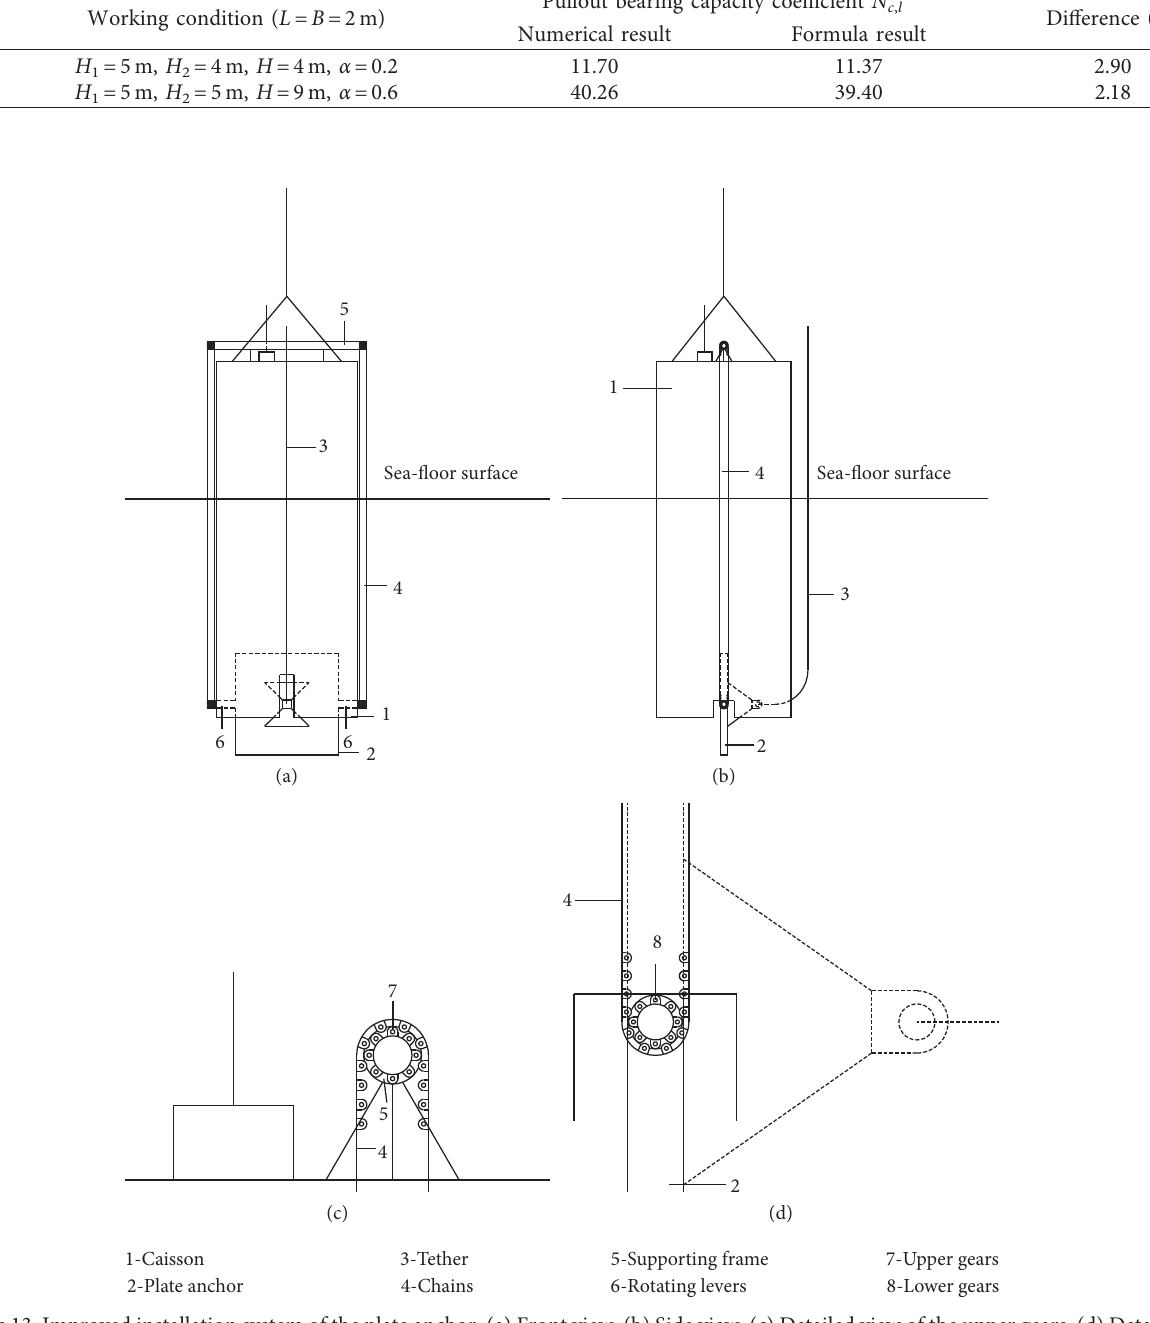
Figure 13: Improved installation system of the plate anchor. (a) Front view. (b) Side view. (c) Detailed view of the upper gears. (d) Detailed view of the lower